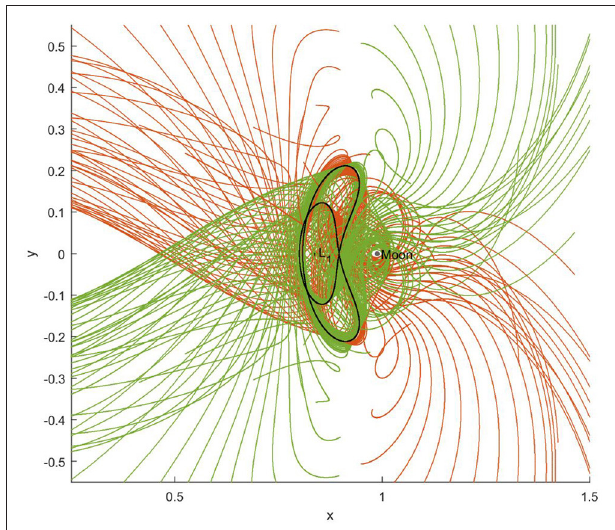
FIGURE 3 | Trajectories along the solar-sail assisted stable (green) and unstable (red) manifolds of orbit